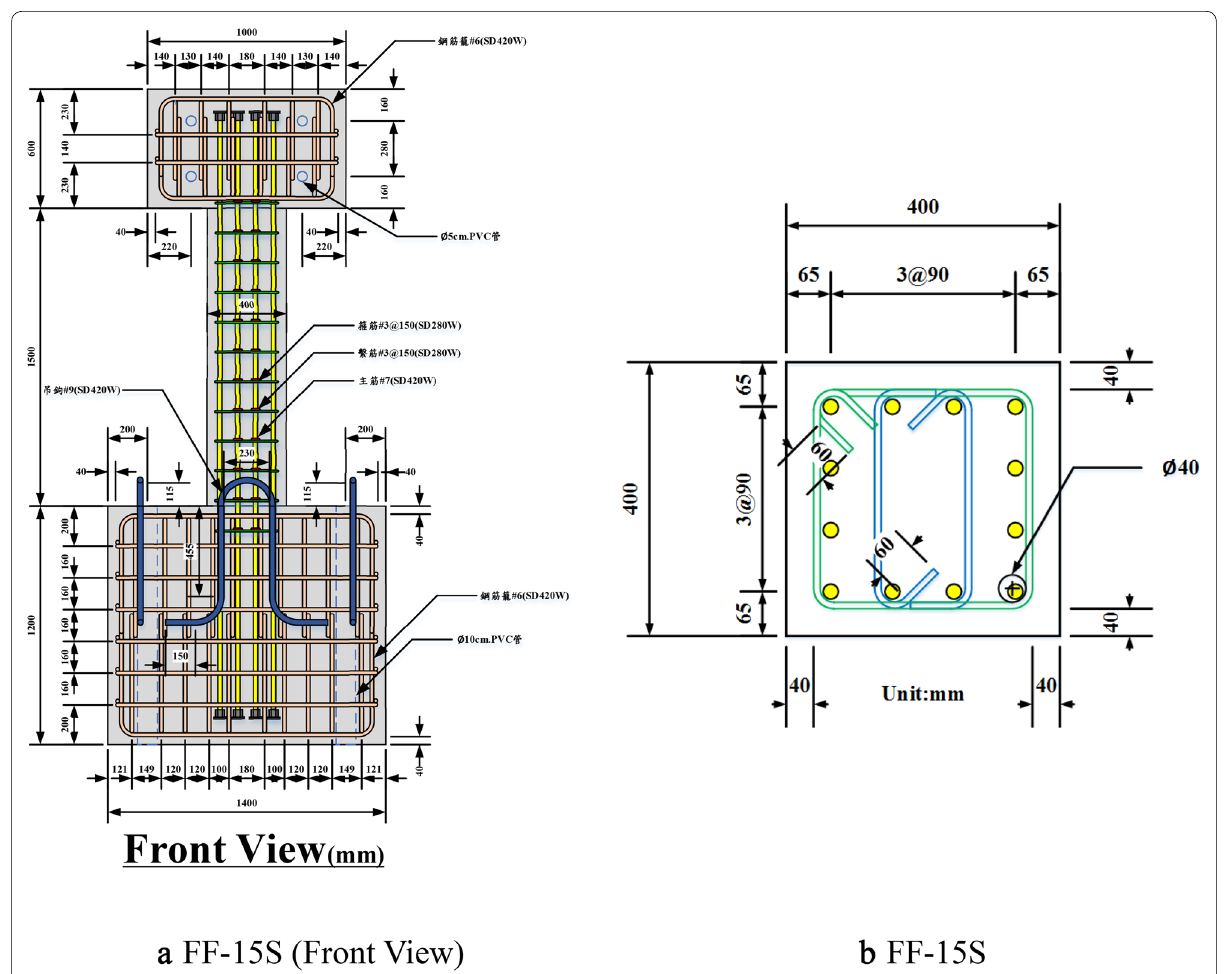
Fig. 3 Detailed reinforcement arrangement of the specimen of